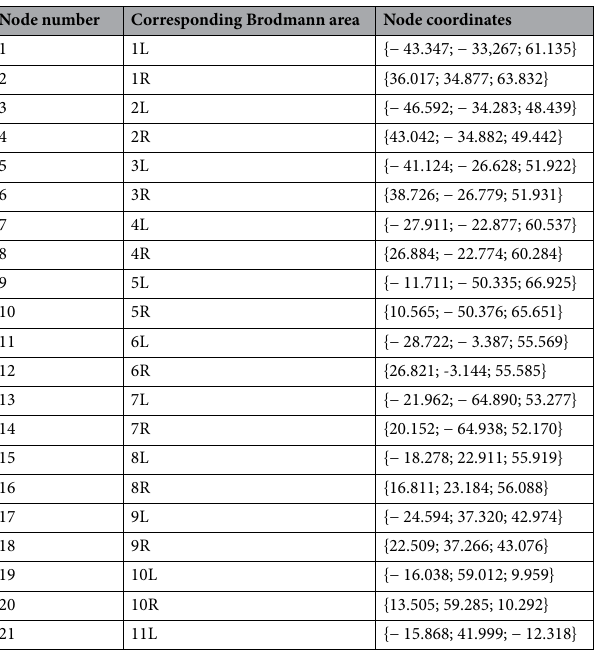
Table 1. Table of conversion of Brodmann areas, the corresponding node number in the connectome model and the Talairach space. The table shows correspondences only up to node 21. All data on the conversion can be found at the following Internet address: https:// github. com/ ZhenY angCMI/ BIRD_ code/ tree/ master/ dynam icAna lysis/ Brain NetVi ewer/ Data/ Examp leFil es/ Brodm ann82. See also the SI